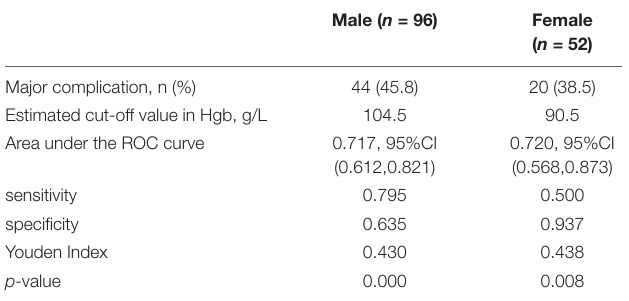
TABLE 3 | Estimation of the cut-off values of